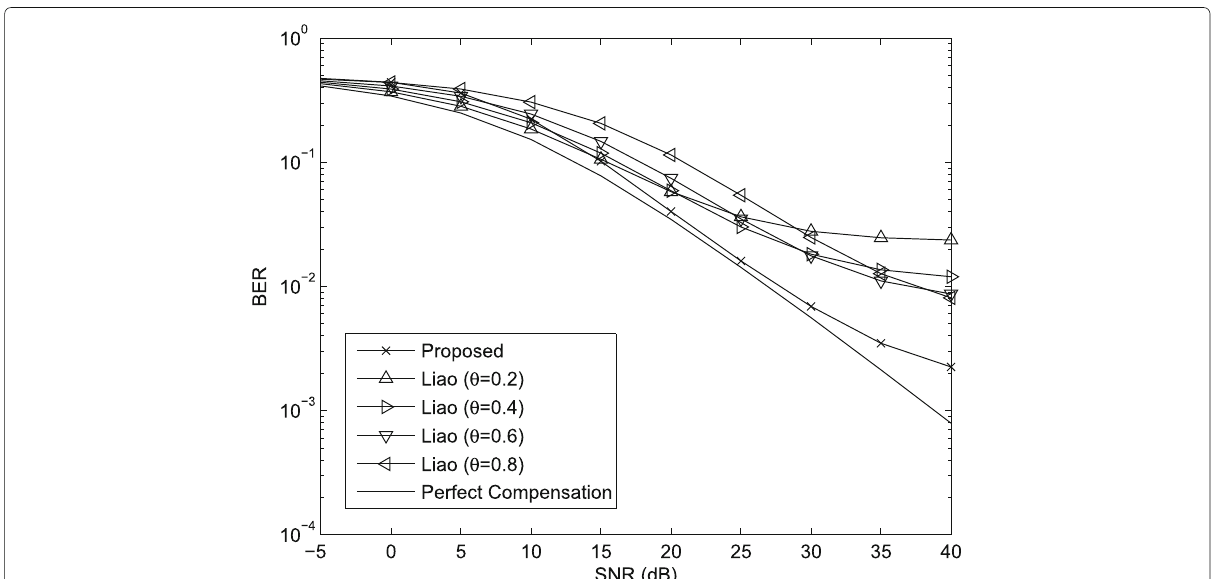
Fig. 5 Comparison of the BER for K = 500. We compare the BER performances of our method with the method proposed by Liao et al. in [34]. The parameter θ in Liao’s algorithm is set to 0.2, 0.4, 0.6, and 0.8. The number of received blocks is K = 500